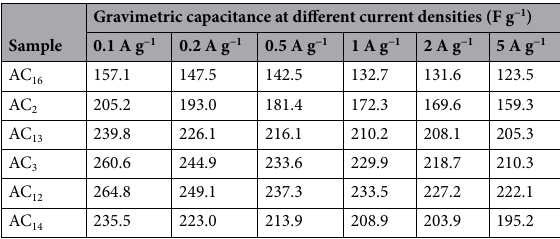
Table 10. Gravimetric capacitance of SACs at different current densities.